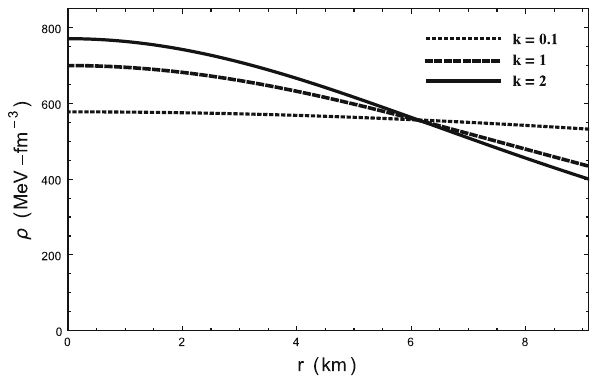
Fig. 1 Radial dependance of density ρ